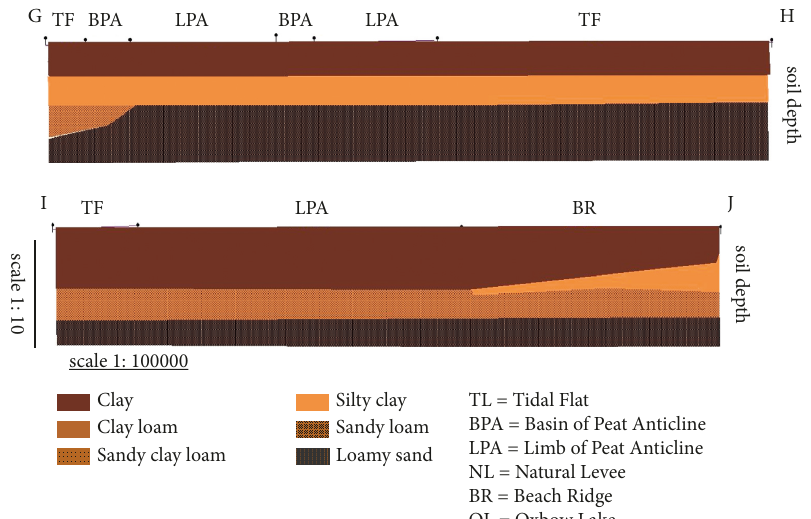
Figure 8: Soil profile for cross-section GH and IJ in Barito Delta. The location of cross-section GH and IJ can be checked in Figure 1. It is constructed based on the result of interpolation of soil fraction applying Bayesian statistics. Horizontal axis is land surface, while soil depth is vertical axis. Horizontal and vertical scales are different for layout configuration only.